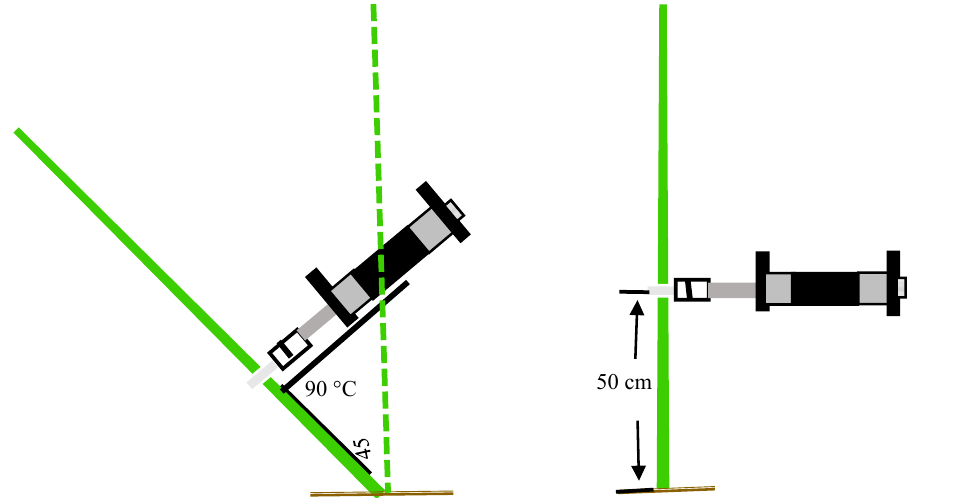
Figure 1. Schematic diagram of the measure method of pushing resistance.